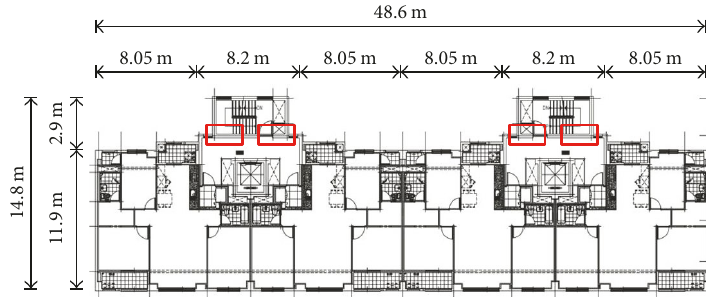
Figure 22: A 15-story apartment RC structure and damper installation